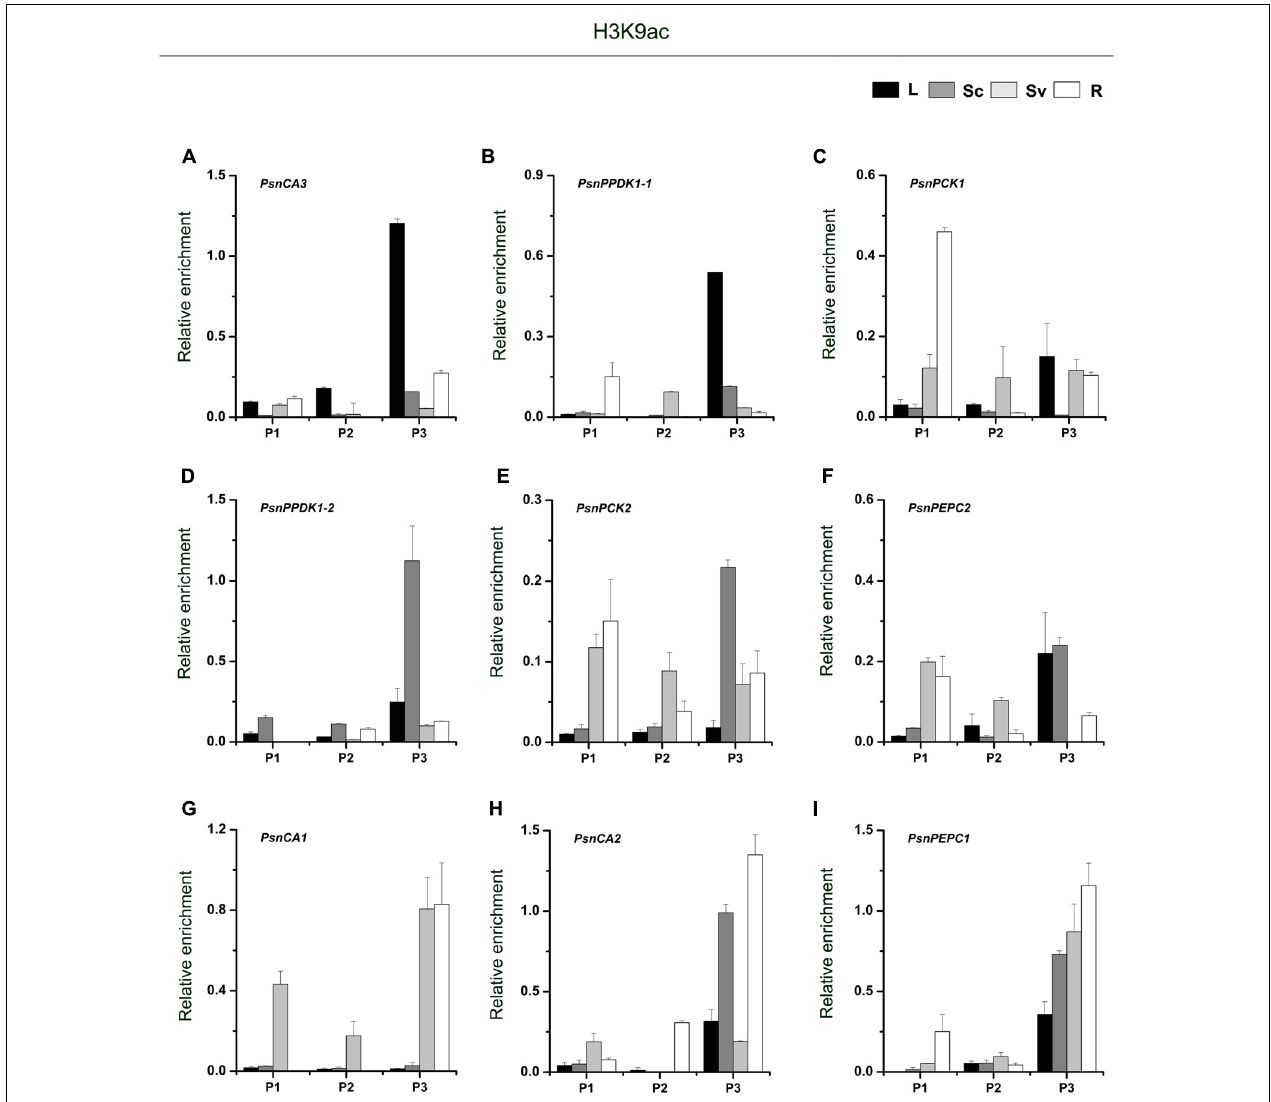
FIGURE 3 | ChIP analysis of the PsnCA , PsnPPDK , PsnPCK , and PsnPEPC gene promoters using the H3K9ac antibody. (A–I) All tissues were harvested from 5-month-old poplar plants grown in a greenhouse 4 h after the onset of illumination. ChIP was used to detect H3K9ac levels in the upstream promoters of the PsnCA , PsnPPDK , PsnPCK , and PsnPEPC genes in leaves (L), stem chlorenchyma (Sc), stem vascular tissue (Sv), and roots (R). P1, P2, and P3 represent the distal, middle, and proximal promoter regions (Supplemental Figure S4). Levels of H3K9ac were standardized by the accumulation of H3K9ac in the promoter of the PsnACTIN2 gene (Supplemental Figure S5). Values are the means from three independent experiments. Bars indicate